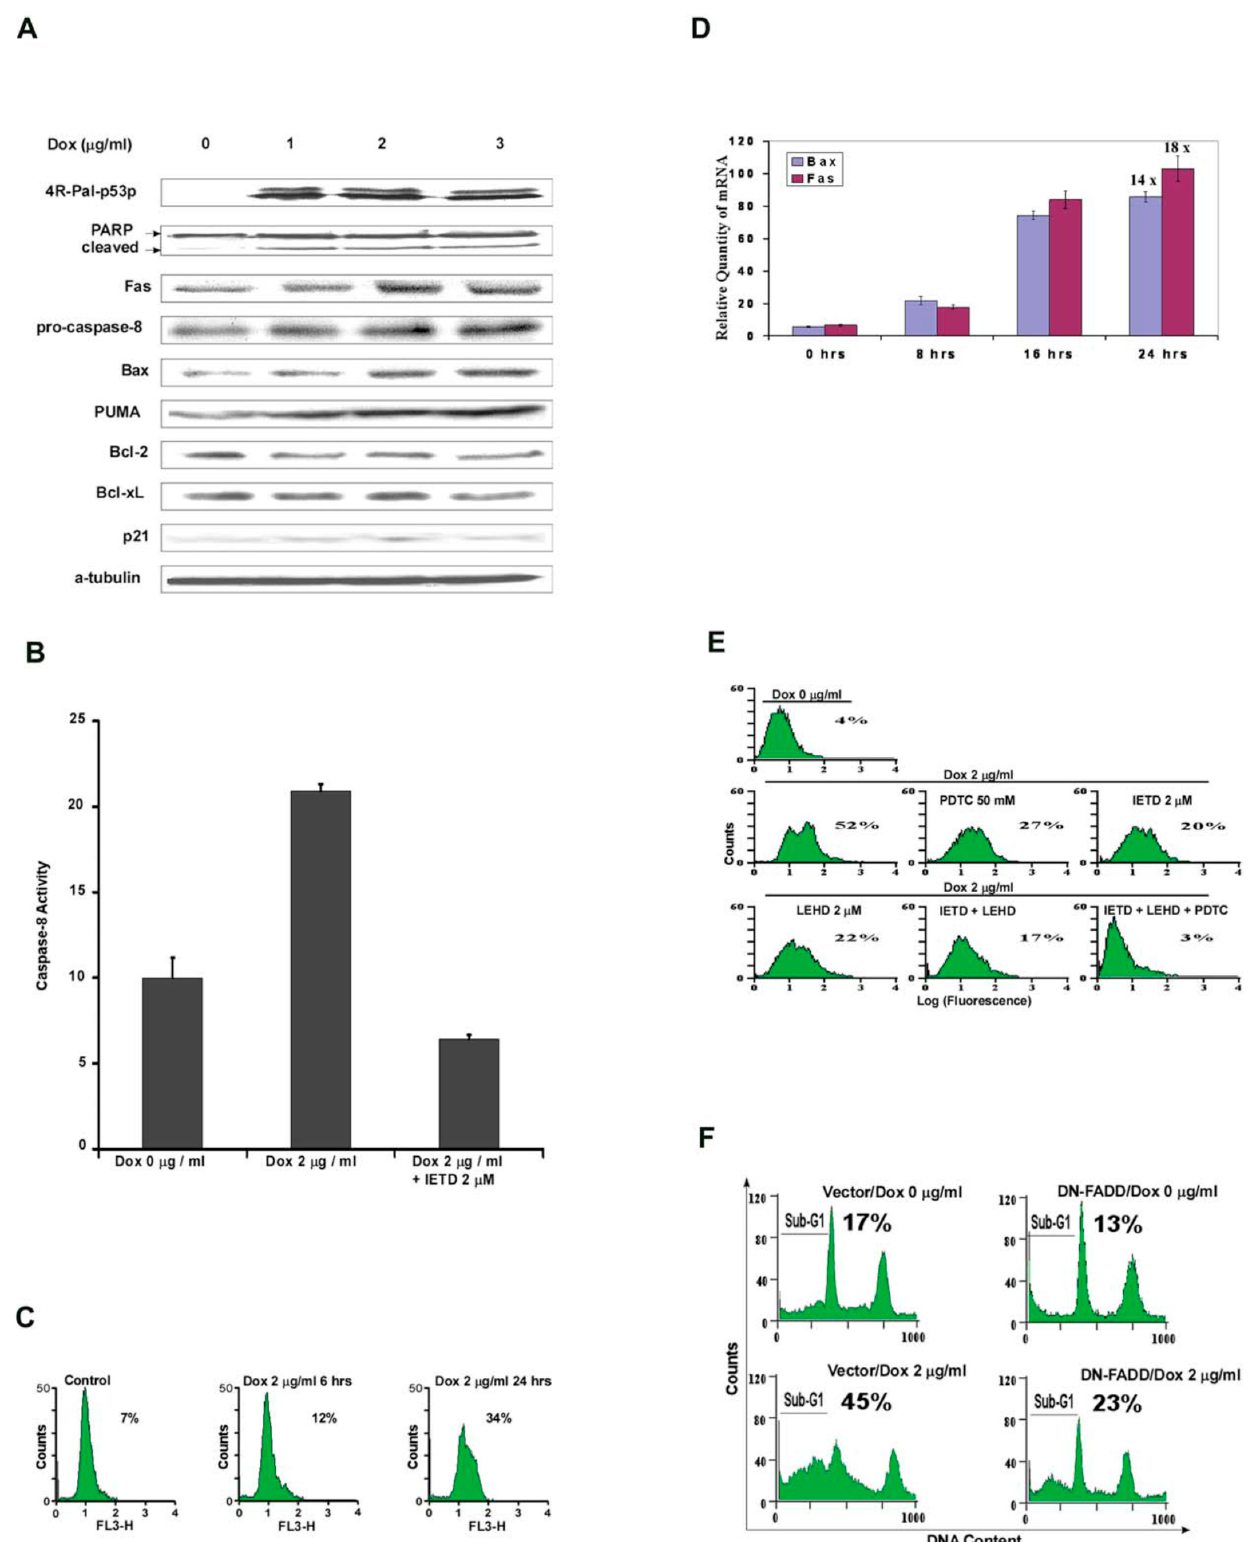
Figure 3. ( A ) Changes in the protein expression levels for the pro-apoptotic p53 target genes for the intrinsic and extrinsic pathways of apoptosis . Endogenous protein expression induced by